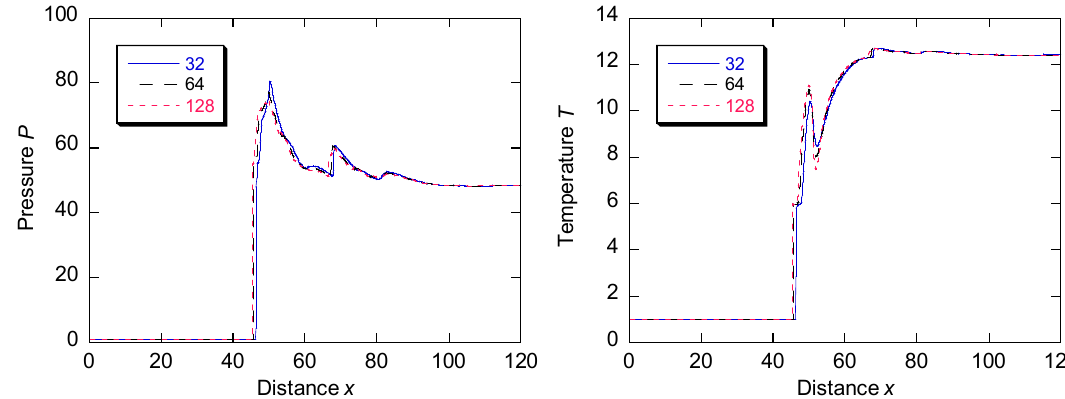
Figure 4. Pressure (left) and temperature (right) profiles along the line y = 0 5 obtained using different grid resolutions with M 0 = 10.0, θ = 30° and k R = 2.8 for the two-step induction-reaction kinetics.